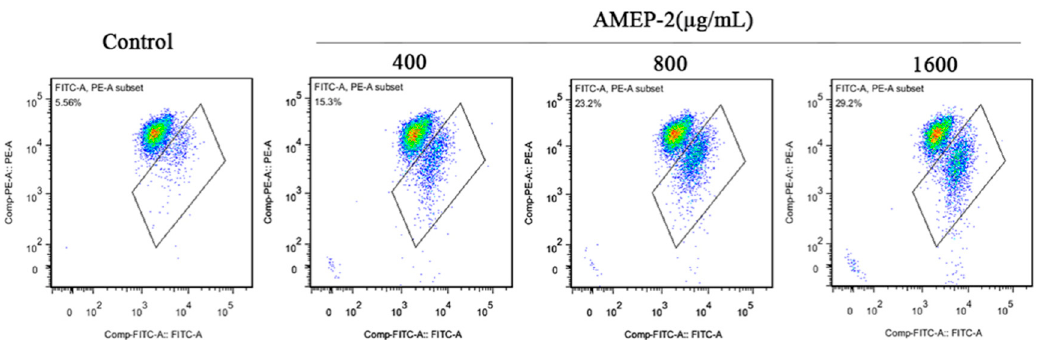
Figure 8. Effect of AMEP-2 on the mitochondrial membrane potential in BGC-823 cells.